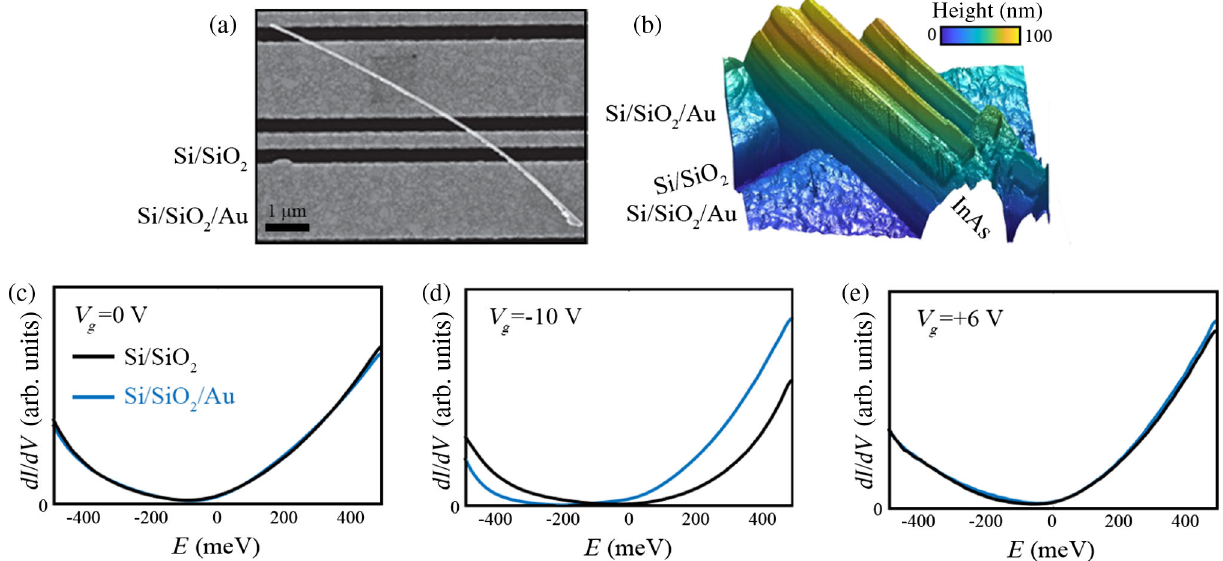
FIG. 10. (a) SEM image of a gatable nanowire device for STM measurement. 100 nm Au film is deposited over doped Si = SiO 2 substrate. Focused ion beam is then used to remove Au along 200 nm wide strips exposing the SiO 2 layer beneath. Nanowires are then deposited in situ . (b) Topographic image obtained in a STM operated at room temperature of a nanowire across a carved trench in the 0 we find no change in the dI=dV spectrum of the nanowire segment that rests on Au to that Si = SiO 2 = Au substrate. (c) At V g ¼ − 10 V, the dI=dV spectrum of the suspended over SiO 2 (blue versus black, respectively). (d) In response to application of V g ¼ suspended segment of the nanowire is shifted by about 100 meV with respect to that measured over a segment resting on Au. To remove the setpoint effect, in which the STM feedback maintains a constant integrated LDOS between zero and parking bias by adjusting the tip to sample height, the spectra are normalized by the integrated LDOS in the 300 meVenergy window above the onset of the conduction 6 V due to Fermi level band. (e) No significant response in the dI=dV to application of positive bias of V g ¼ þ